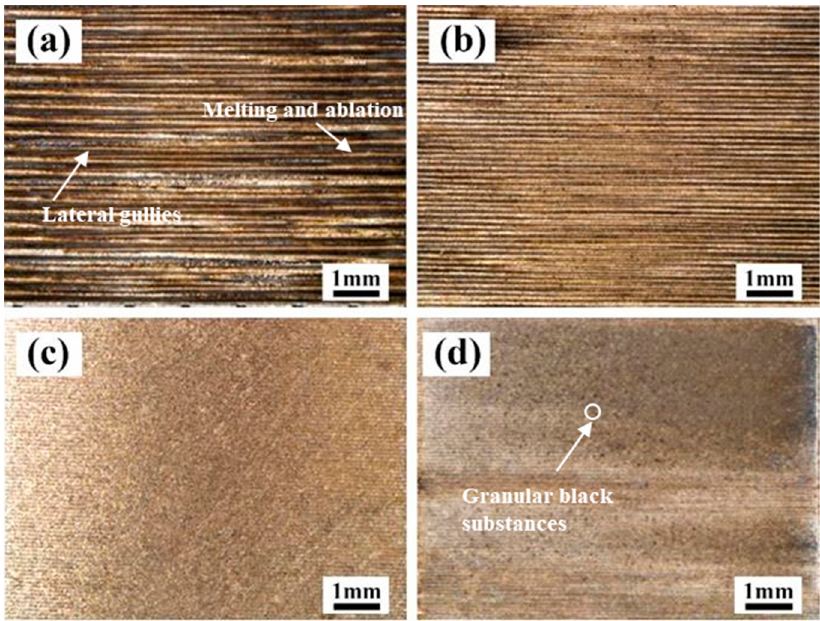
Figure 3. The effect of laser X-scanning speed on the macro morphology of the cleaned surface of Q345 steel at a laser Y-moving speed of 7 mm/s. ( a ) 500 mm/s; ( b ) 1000 mm/s; ( c ) 1500 mm/s; ( d ) 2000 mm/s.